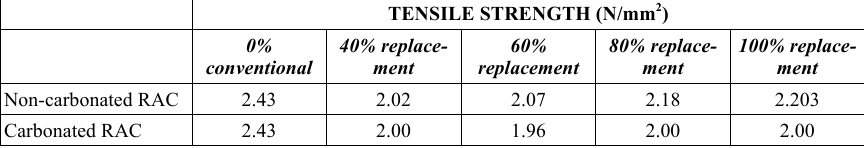
Table 5. Tensile strength of non-carbonated and carbonated recycled aggregate